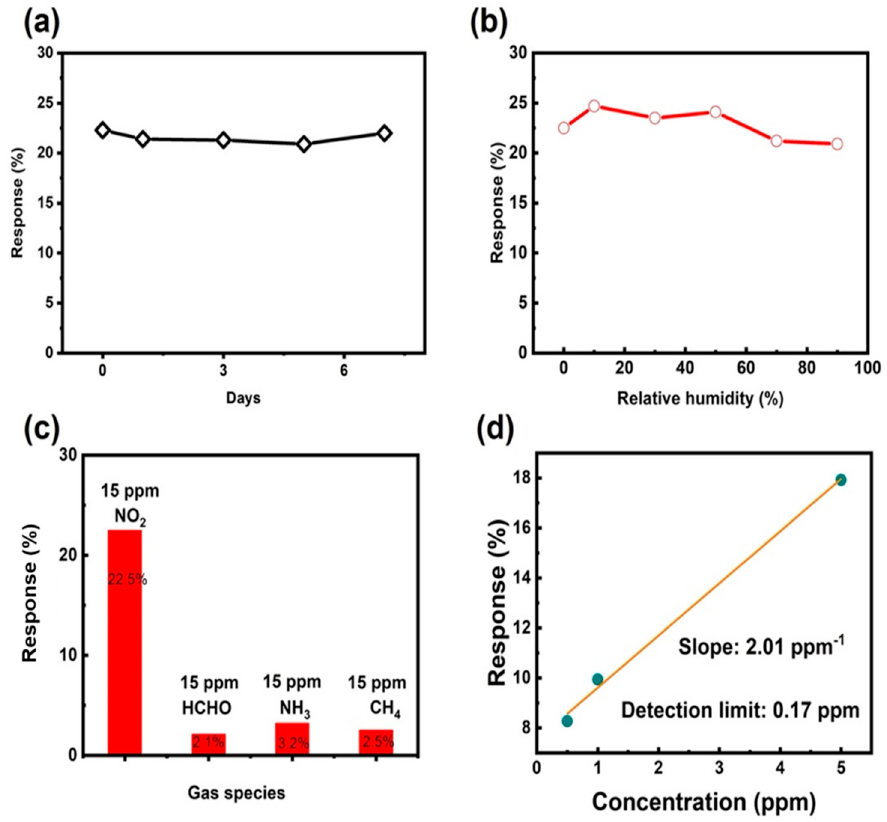
Figure 6. Stability, humidity, selectivity, and detection limit test of the rGO gas sensor prepared by spin coating. ( a ) Stability of gas sensor among one week. ( b ) Relative humidity–response curve. ( c ) Selectivity of gas sensor to different gases, including NO 2 , HCHO, NH 3 and CH 4 . ( d ) Theoretical detection limit of the gas sensor responded to NO 2 .